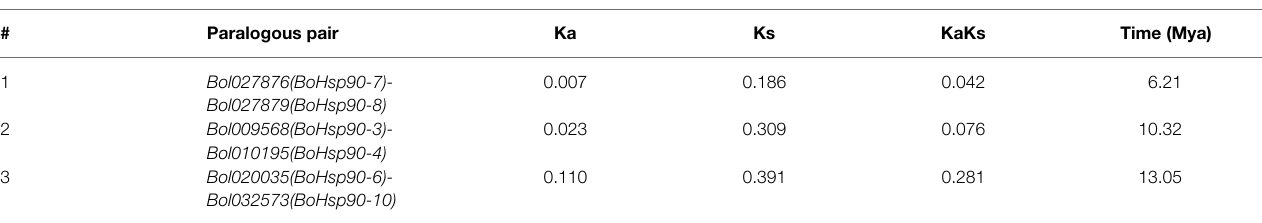
TABLE 1 | Duplicated BoHsp90 genes in